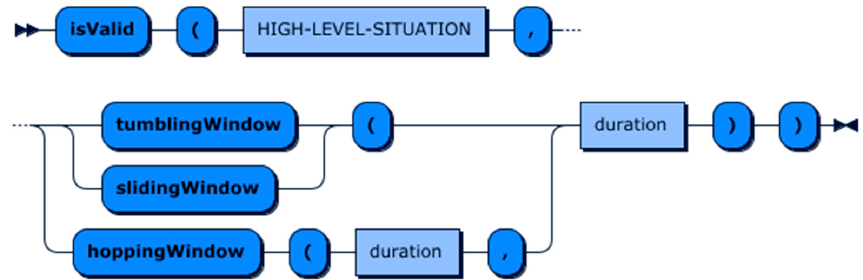
Figure 23. isValid function production rule.